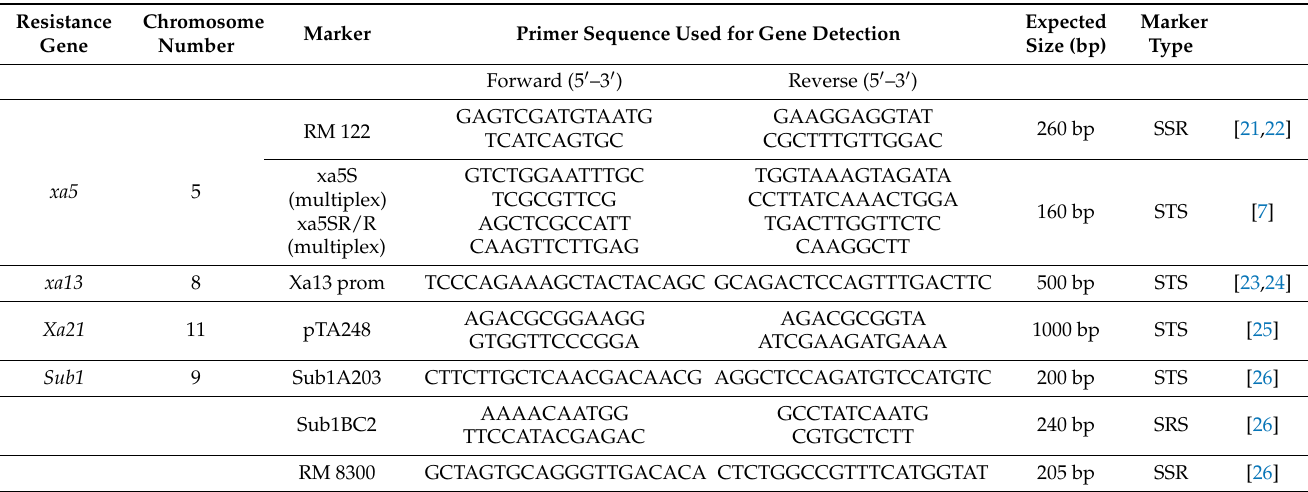
Table 1. Markers used for the selection of submergence tolerance QTL Sub1 and three BB resistance genes in the backcross